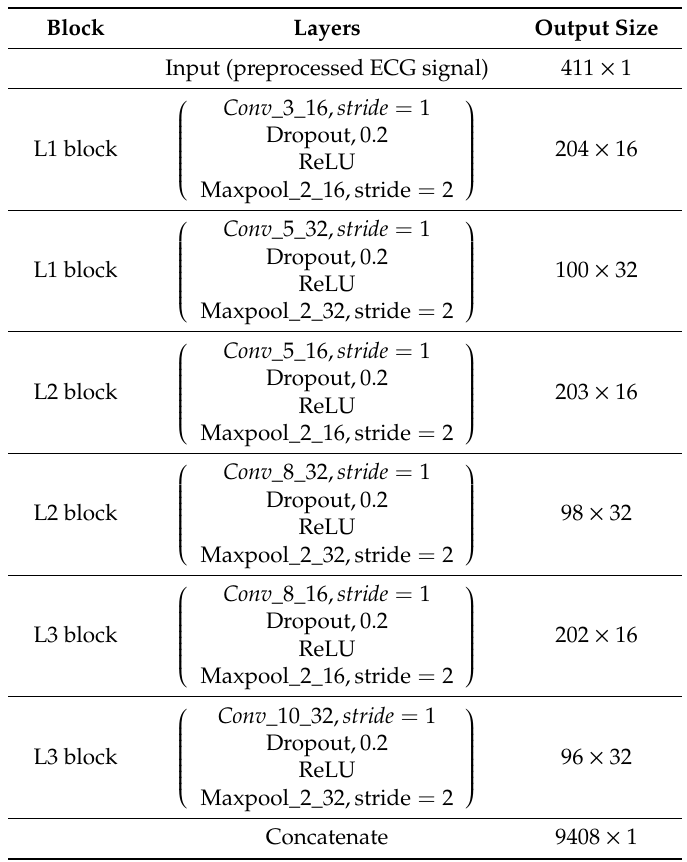
Figure 5. The structure of the feature extractor block. ReLU: Rectified Linear Unit. Table 3. A summary table of the multi-scale feature extractor (F) block. ReLU: Rectified Linear